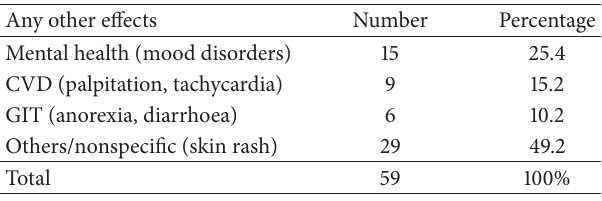
Table 4: Classification of any other